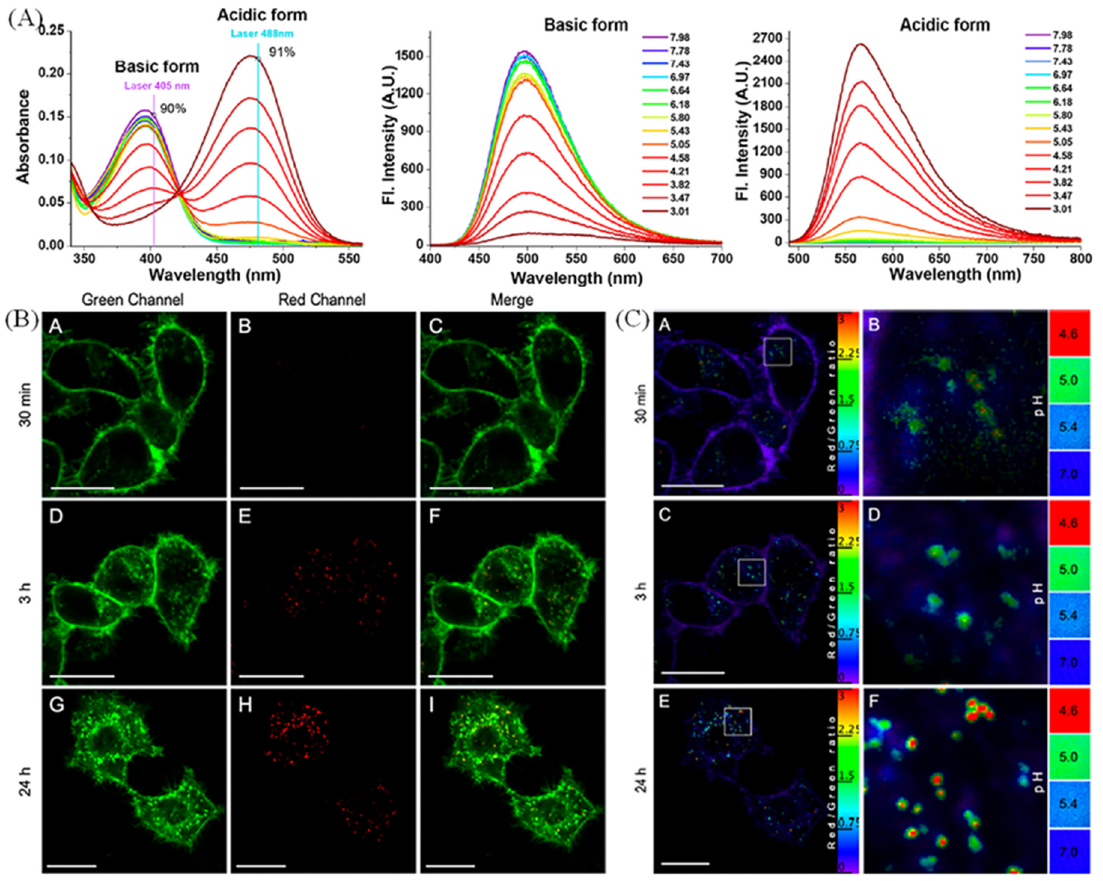
Figure 16. ( A ) Absorbance and fluorescence spectra of probe in solutions with diverse pH values.